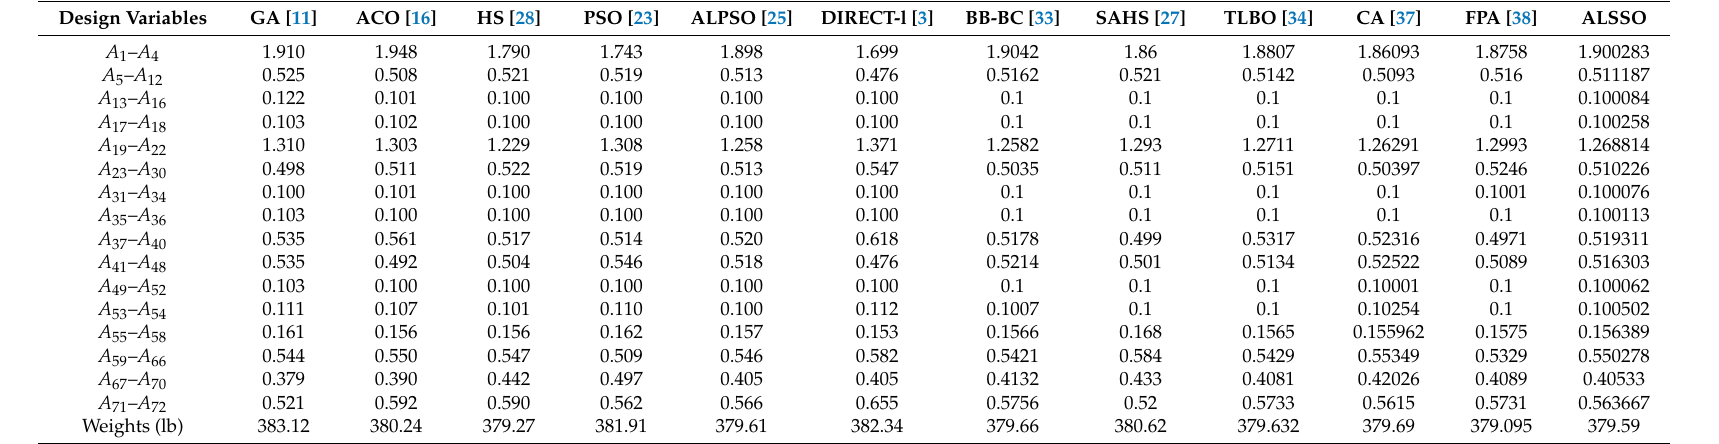
Table 8. Comparison of optimized designs for the 72-bar truss